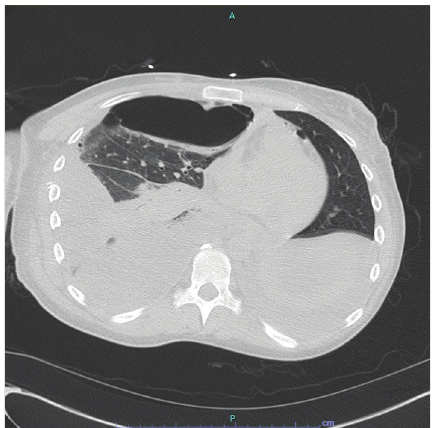
Figure 1: Computed tomography (CT) of the chest without contrast: moderate-large loculated right pneumothorax anteriorly with mediastinal shift to the left suggesting tension component and small volume pneumomediastinum.